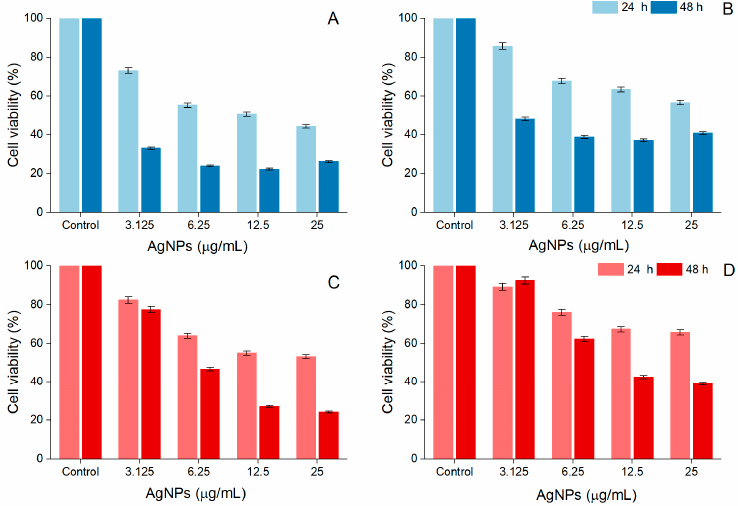
Figure 7. Viability of A-375 human malignant melanoma cells exposed to Abies alba ( A ) and Pinus sylvestris bark extract-derived AgNPs ( C ); viability of African green monkey kidney (Vero) cells exposed to Abies alba ( B ) and Pinus sylvestris bark extract-derived AgNPs ( D ); signi fi cant di ff erences ( p < 0.001) between Abies alba / Pinus sylvestris bark extract-derived AgNPs (at all tested concentrations) and control.